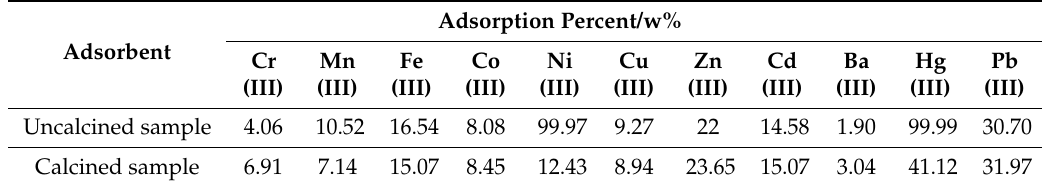
Table 4. Adsorption percentage of metal ions on the lanthanum phosphate in aqueous media.